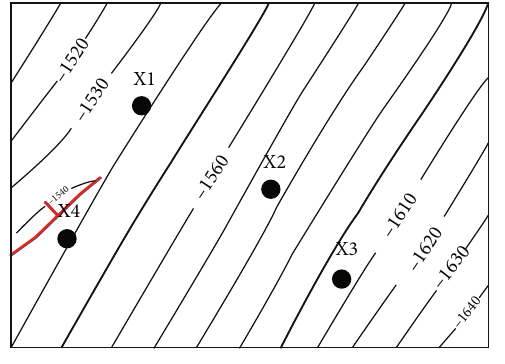
Figure 11: Well location diagram.